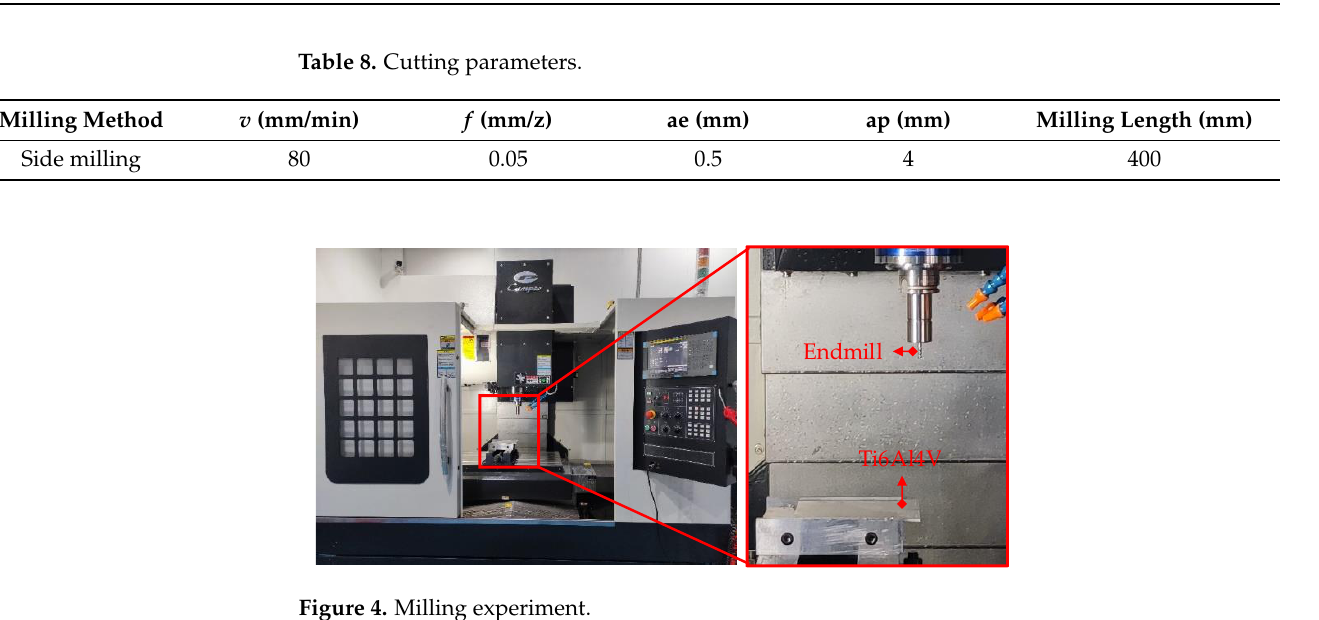
Table 6. Properties and compositions of the cemented carbide samples.